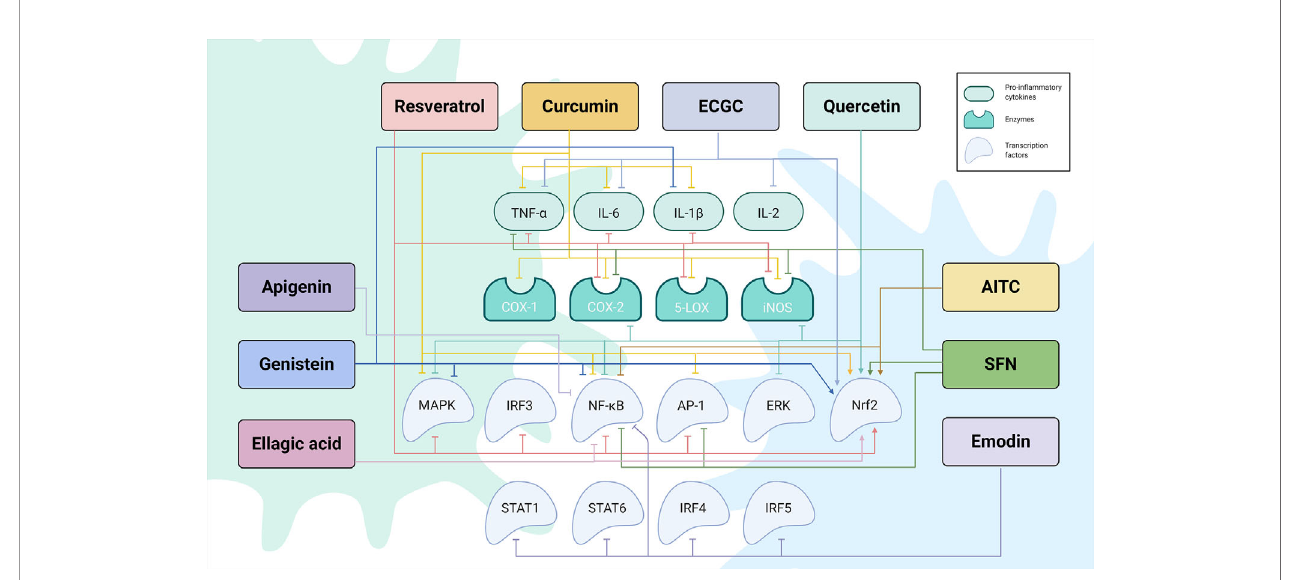
FIGURE 2 | The regulatory network by which phytochemicals affect TLR4-mediated in fl ammatory responses. Created with